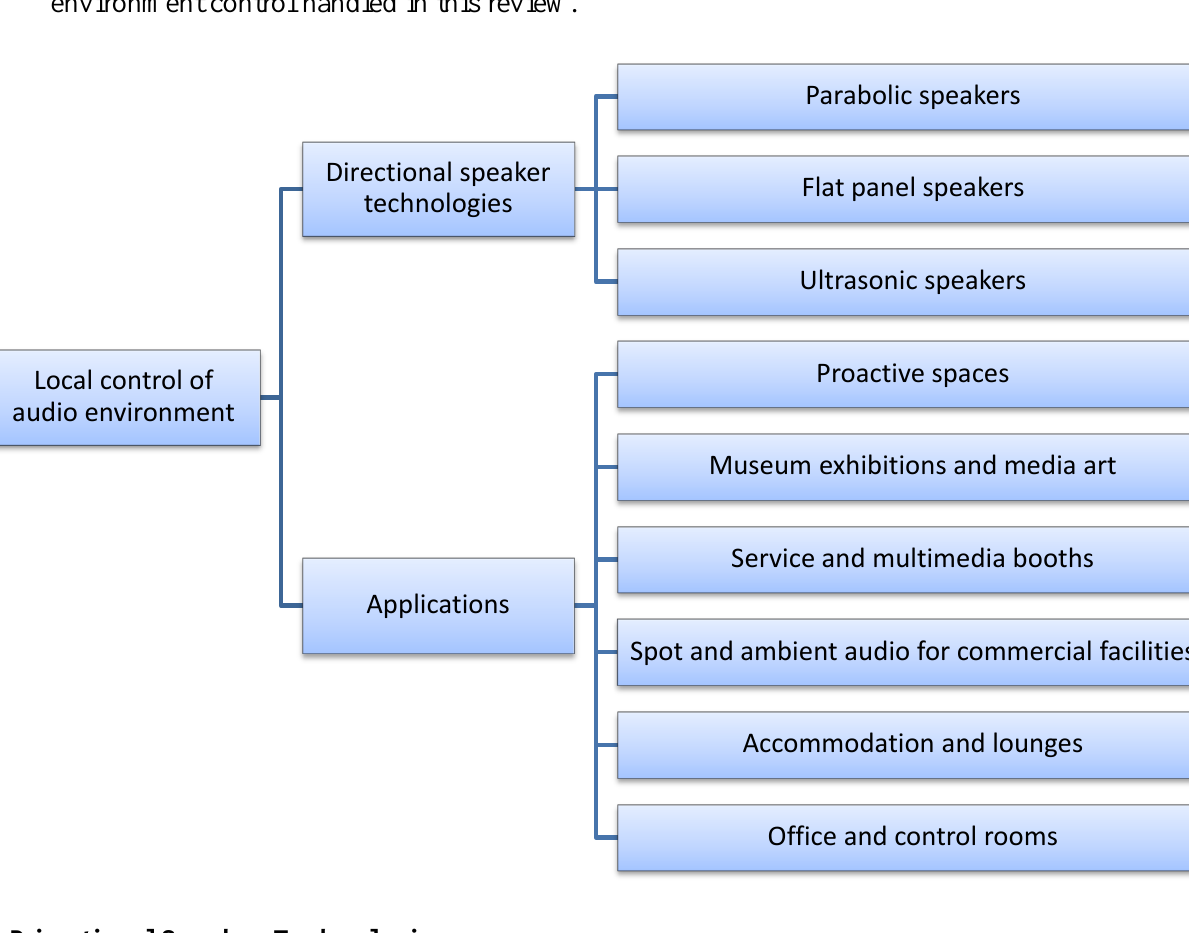
Figure 1. Overview of the directional speaker technologies and applications of local audio environment control handled in this